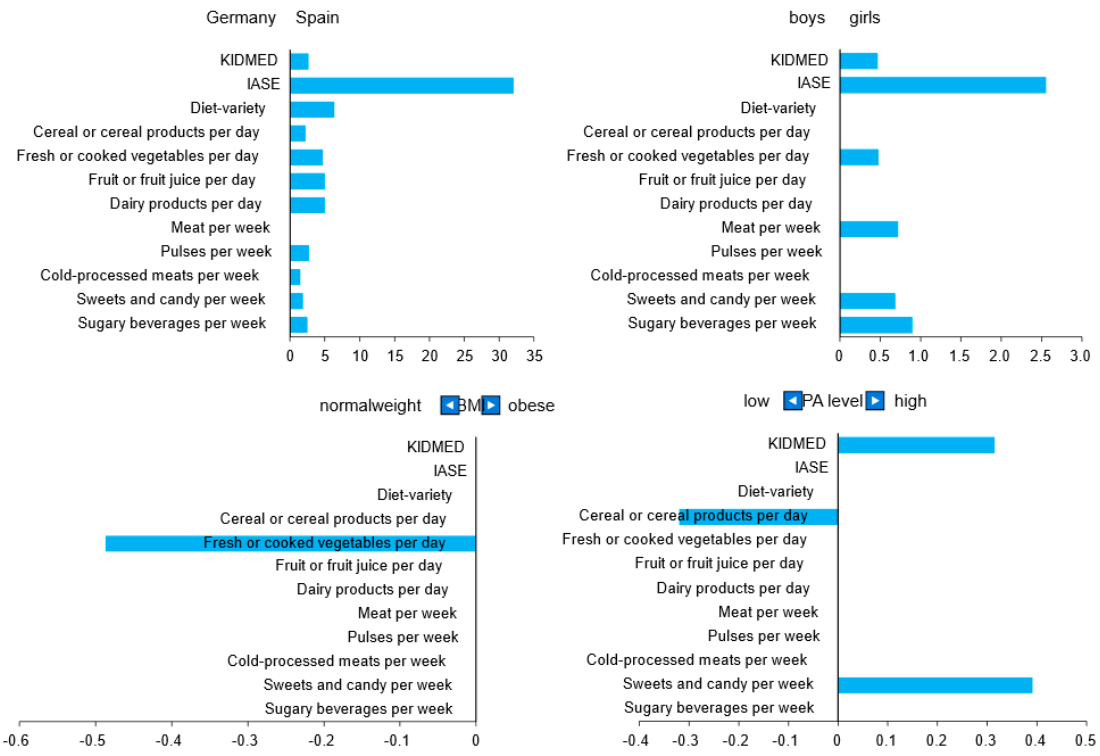
Figure 3. Regression coefficients for KIDMED and IASE and its variables for country, gender, BMI group, and PA level. PA: Physical activity; IASE: Healthy feeding